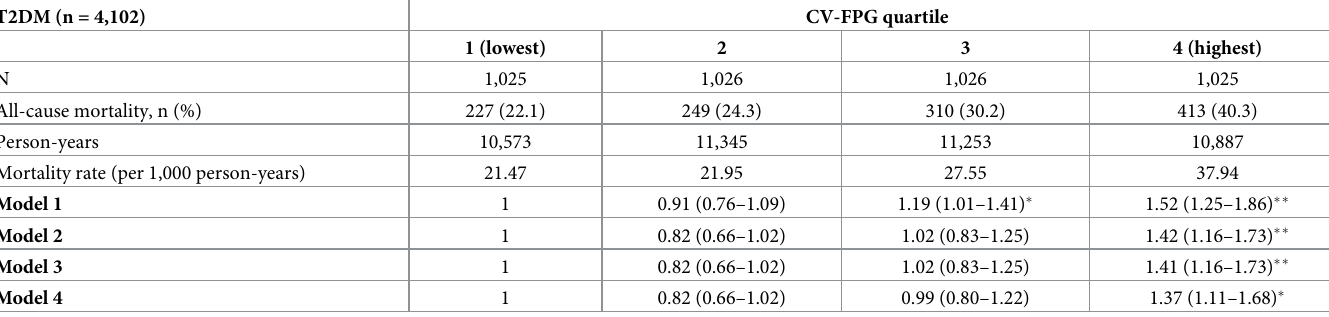
Model 1: adjusted for age and sex. Model 2: adjusted for age, sex, and history of cardiovascular disease. Model 3: adjusted for variables in model 2 plus hypertension, use of aspirin and statins. Model 4: Model 3 plus use of GLP-1 receptor agonists, SGLT-2 inhibitors and DPP-4 inhibitors, baseline FPG and average HbA1c (when at least two measurements) � p < 0.05